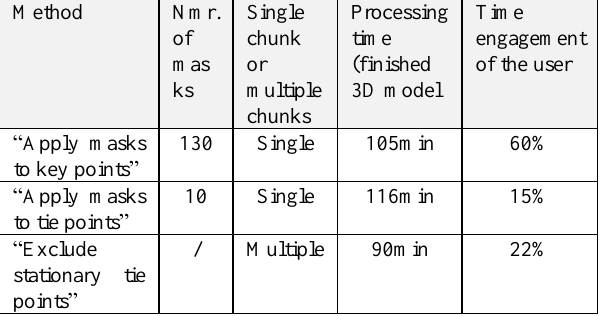
Table 1: Comparison of different methods for the photo alignment process